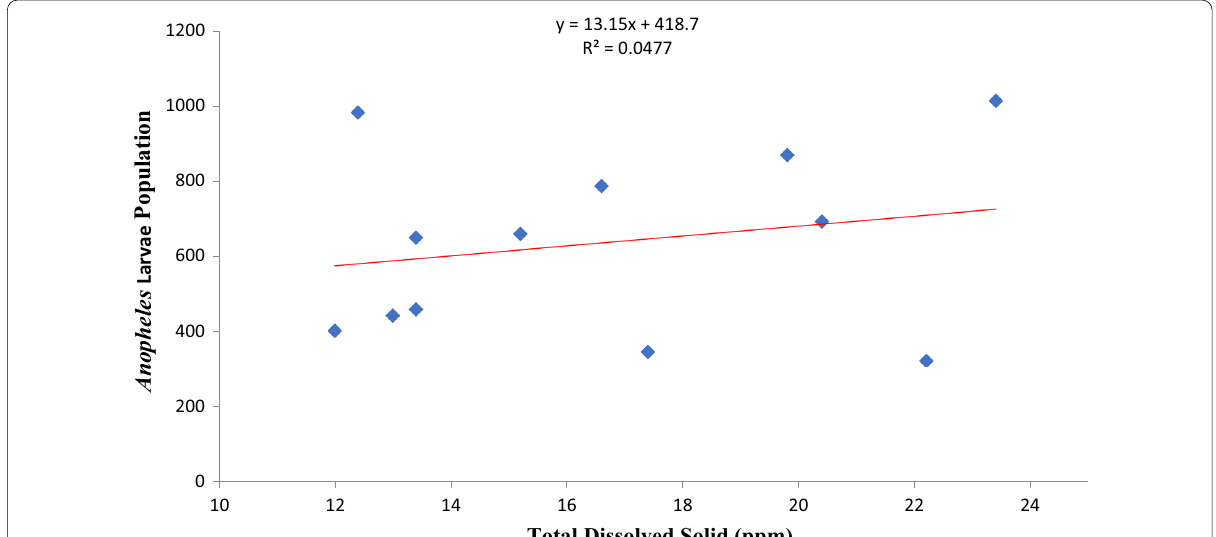
Fig. 6 Regression relationship between Anopheles larvae population and total dissolved solid values (µS/cm) of habitats in Akure North LGA